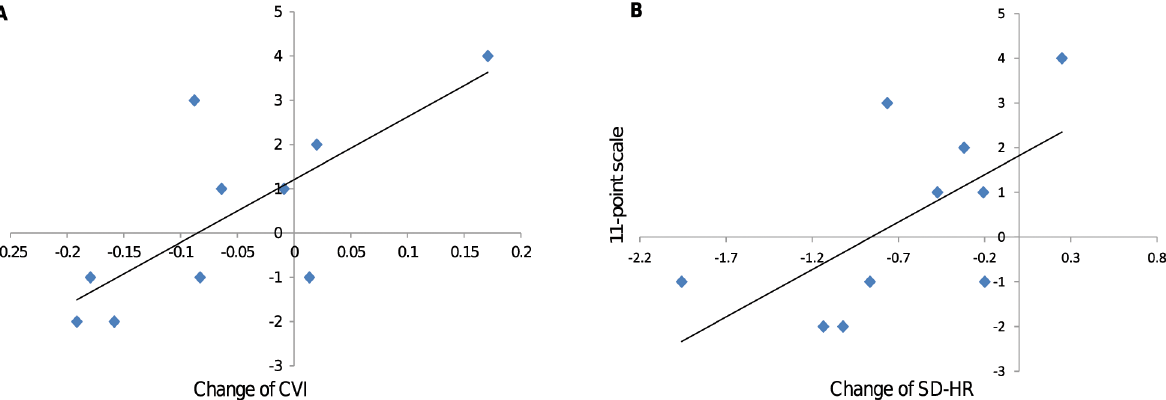
Fig 4. Relations between ANS and postdictive time perception. (A) Correlation of the change of CVI with 11-point scale for the control group, and (B) correlation of the change of SD-HR with 11-point scale for the control group. The change was defined as subtracting the value in the second trip session